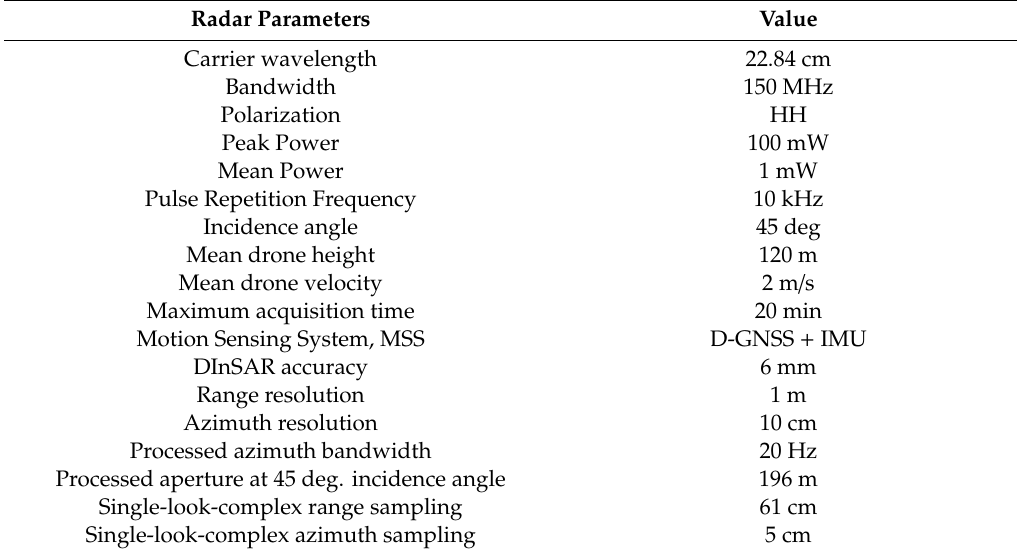
Table 1. Main parameters of radar